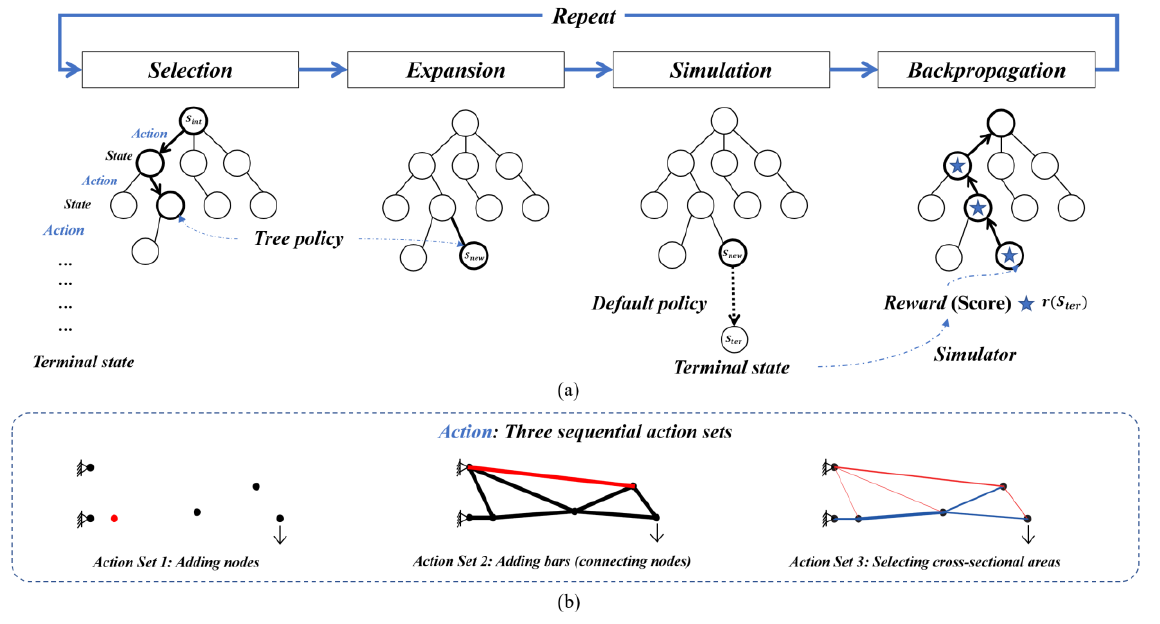
Figure 2. Description of Monte Carlo Tree Search in AlphaTruss. ( a ) Four steps in MCTS to solve the MDP model of truss layout design; ( b ) Three sequential action sets in truss generation MDP model. The most common selection strategy for MCTS is the upper confidence bounds